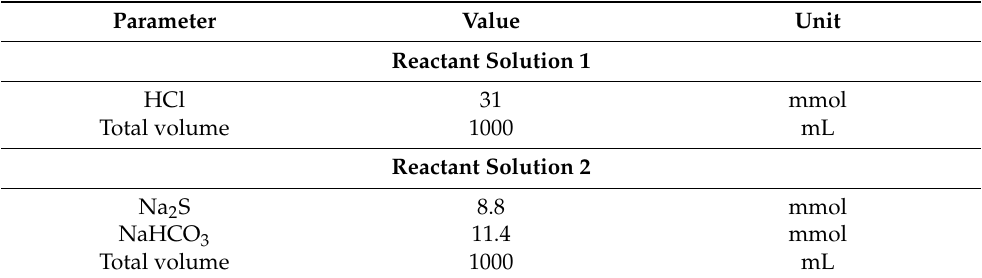
Table 1. Concentration of the reactant species in the reactant solutions.